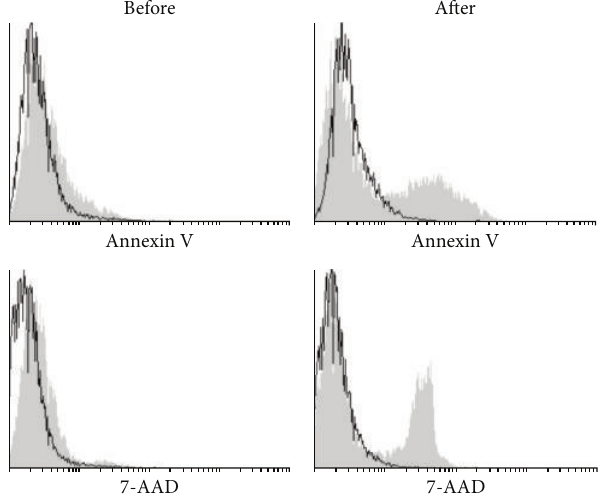
Figure 3: Histograms of Annexin V (apoptosis marker) and 7-AAD (viability marker) of the cells before and after cryopreservation. The grey color represents specific marker and the white color represents an isotype